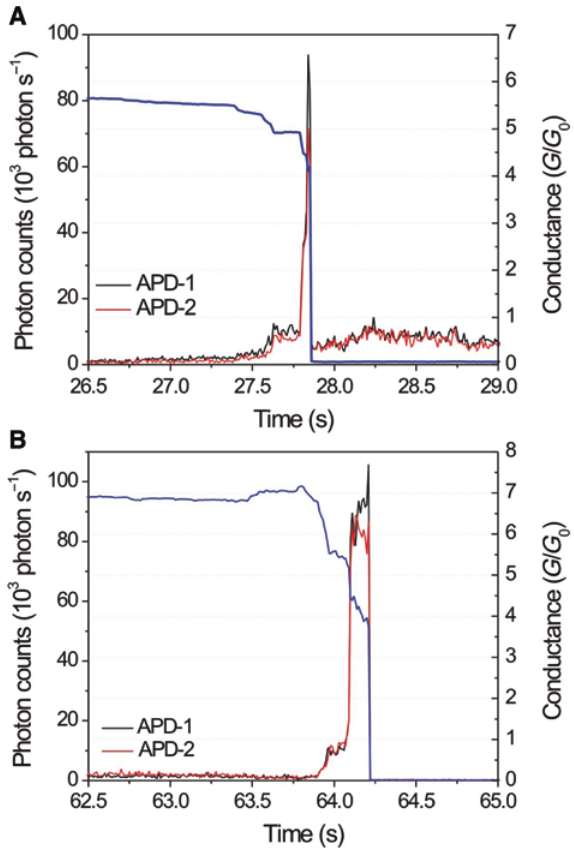
Figure 2: Photon counts and measured conductance versus